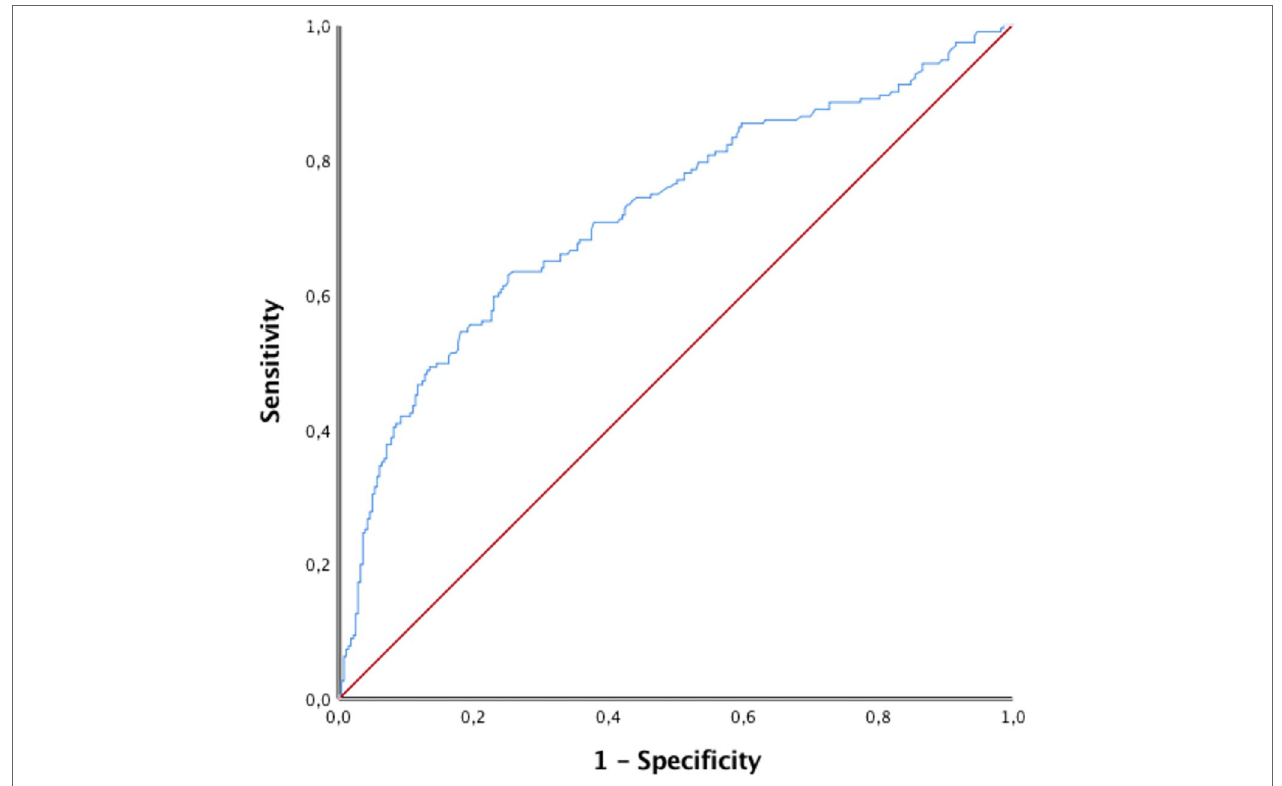
FIGURE 3 | Receiver operating characteristic (ROC) curve for the prediction of violent behavior.